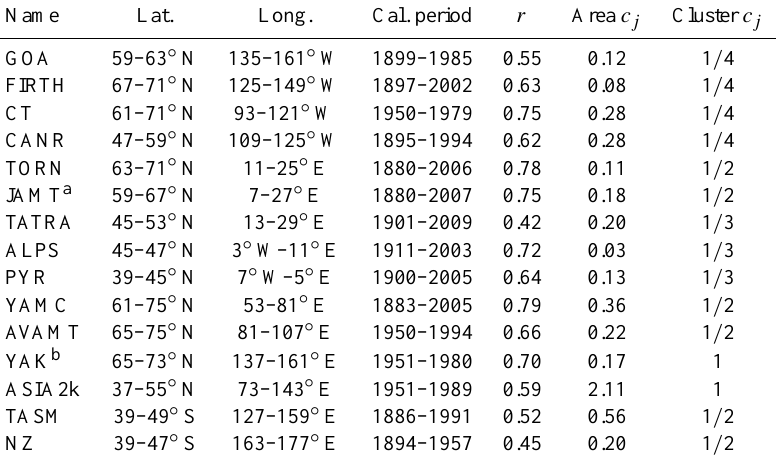
Table 3. Selected information for each region: latitude/longitude boundaries, proxy data calibration period, and correlation r with instru- mental target, area weight c j , and cluster weight c j . The area weights are defined as the fraction of the global area. The cluster weights are explained in the text. Name